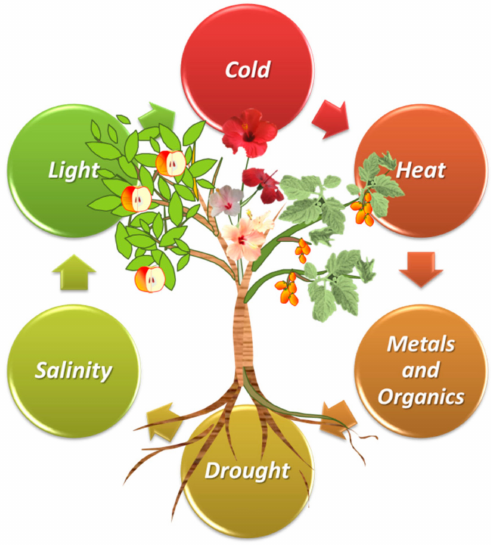
Figure 1. Potential abiotic stresses that can compromise crop yield and produce